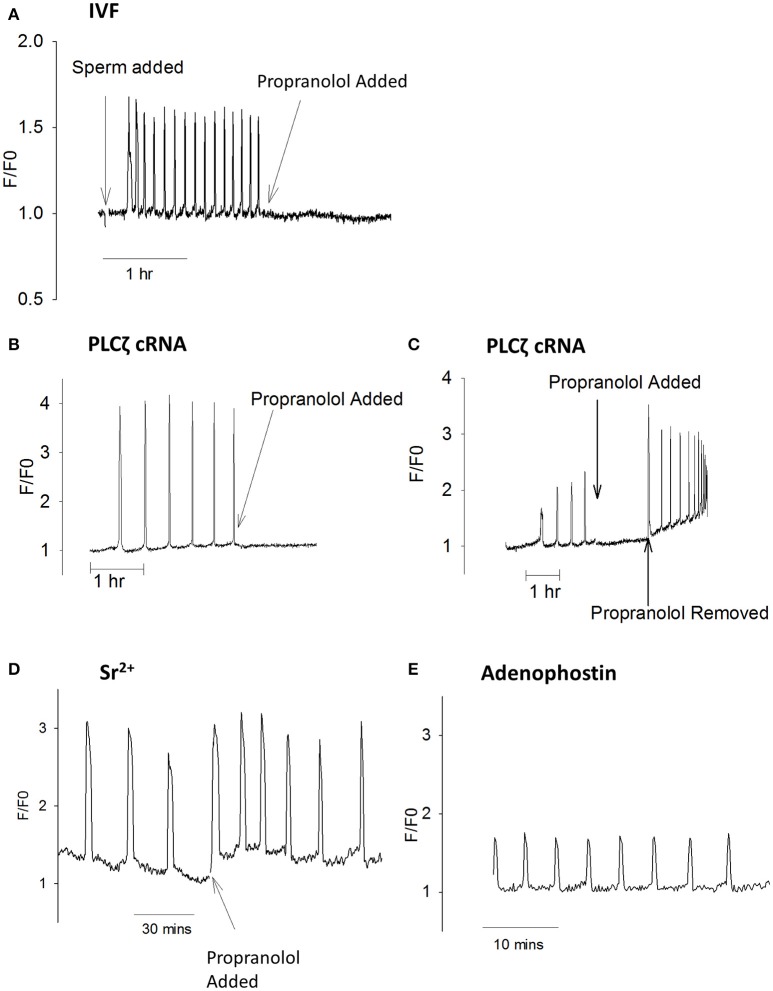
Ca2+ oscillations blocked by propranolol. In (A) an example is shown of a mouse egg undergoing Ca2+ oscillations at fertilization where the addition of 300 μM propranolol inhibited subsequent oscillations (n = 13 eggs). Before addition of propranolol the mean frequency was 12.2 ± 1.14 spikes/h with all eggs oscillating. After adding propranolol there were 0.8 ± 0.23 spikes /h (a significant difference from before propranolol, p = < 0.0001). 6/13 eggs stopped oscillating immediately, 4/13 eggs had one Ca2+ spike, and 3/13 has 2 spikes in an hour. (B) shows PLCζ cRNA (pipette concentration = 0.02 μg/μl) induced Ca2+ oscillations inhibited by propranolol (n = 21 eggs). Before propranolol all eggs oscillated with 4.3 ± 0.46 spikes/h. After addition of propranolol there were 0.95 ± 0.25 spikes/h (a significant difference p < 0.0001). With propranolol, 10/21 eggs stopped Ca2+ oscillations, 6/21 showed a single spike, and 5/21 had >1 Ca2+ spike. In (C) an example is shown of an egg where PLCζ induced Ca2+ oscillations were blocked by the addition of propranolol but then oscillations were restored when propranolol was washed out (typical of n = 8 eggs). Before propranolol, all eggs oscillated with 6.7 ± 1.3 spikes/h. After propranolol this decreased to 1.33 ± 0.29 spikes/h, with all oscillations stopping after 2 spikes. When propranolol was removed there were 10 ± 0.55 spikes in 30 min. Adding propranol and then removing it both caused significant changes in the number of Ca2+ spikes (p < 0.001). (D) shows an example of an egg undergoing Ca2+ oscillations in response to Sr2+ media where propranolol was subsequently added (n = 10 eggs). Before propranolol all eggs oscillated with 4.1 ± 0.29 spikes/h. After adding propranolol all eggs continues to oscillate with 3.9 ± 0.66 Ca2+ spikes/h (not significantly different). In (E) an example is shown of an egg undergoing Ca2+ oscillations in response to microinjection of 5 μM adenophostin in media that contained 300 μM propranolol form the start of the experiment (n = 8 eggs). In propranolol there were 5.5 ± 0.51 Ca2+ spikes 30 min, compared with 10.4 ± 0.71 spikes/30 min (n = 11) for eggs in media with HKSOM. This is significantly different (unpaired t-test, p = < 0.0001).